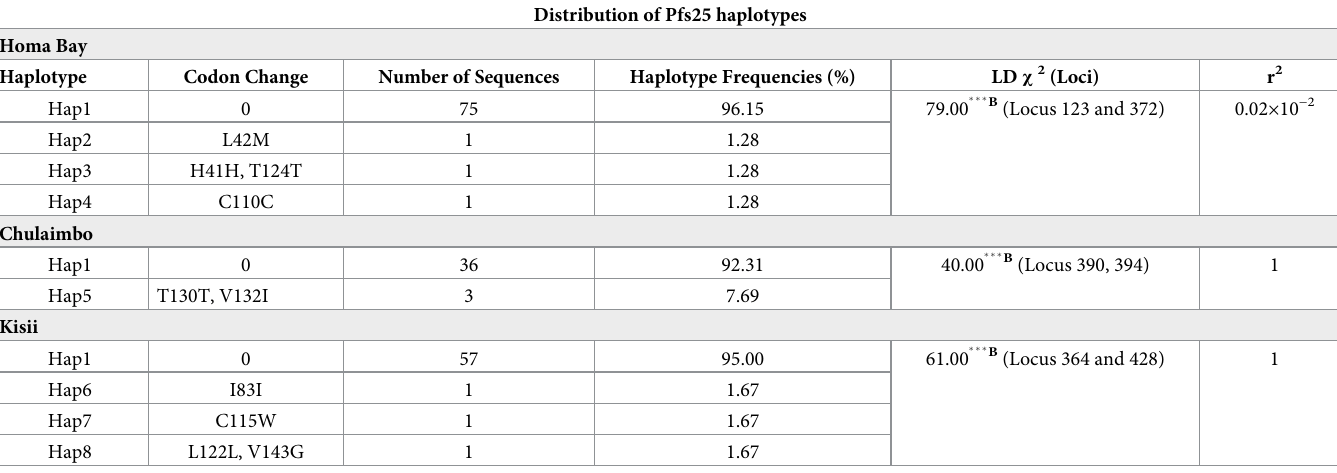
Table 3. Pfs25 haplotypes frequencies across Homa Bay, Chulaimbo and Kisii regions.